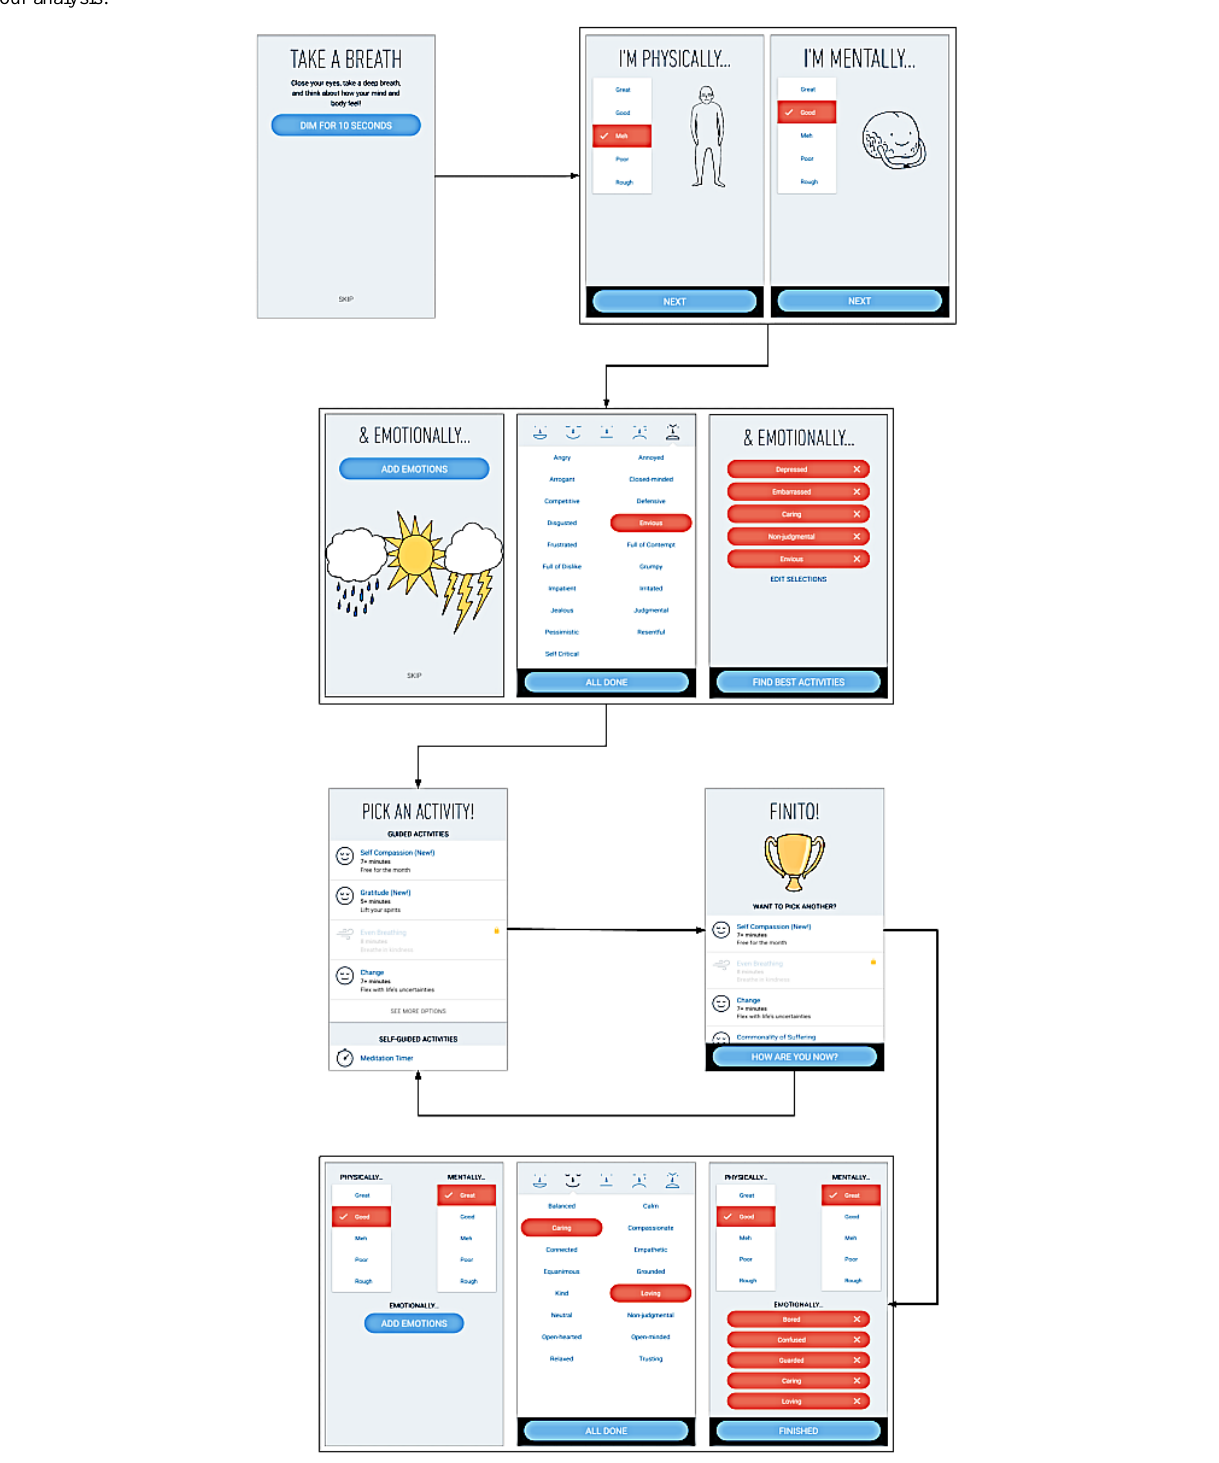
Figure 1. Stop, Breathe & Think (SBT) app user flow diagram. A diagram depicting the users’experience when engaging the SBT app. A natural flow allows the user to reflect, check-in, perform an activity, and then check-in again. Reflections and check-ins are optional but were required data points for our